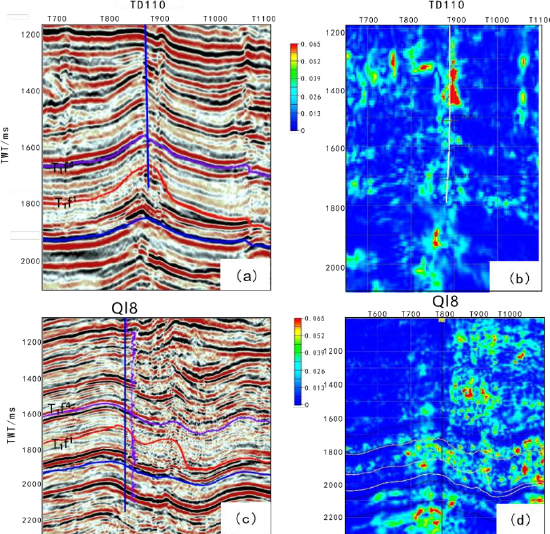
Figure 9. Seismic profiles ( a , c ) and steerable pyramid processed attribute profiles ( b , d ) of well TD110 and Ql8, respectively. The green-red blocks show the fractured reservoirs along the fault damage zone. (T 1 f 4 : fourth member of the Feixianguan Formation in the Lower Triassic; T 1 f: base Feixianguan Formation of the Lower Triassic; P 2 ch: Changxing Formation of the Permian).